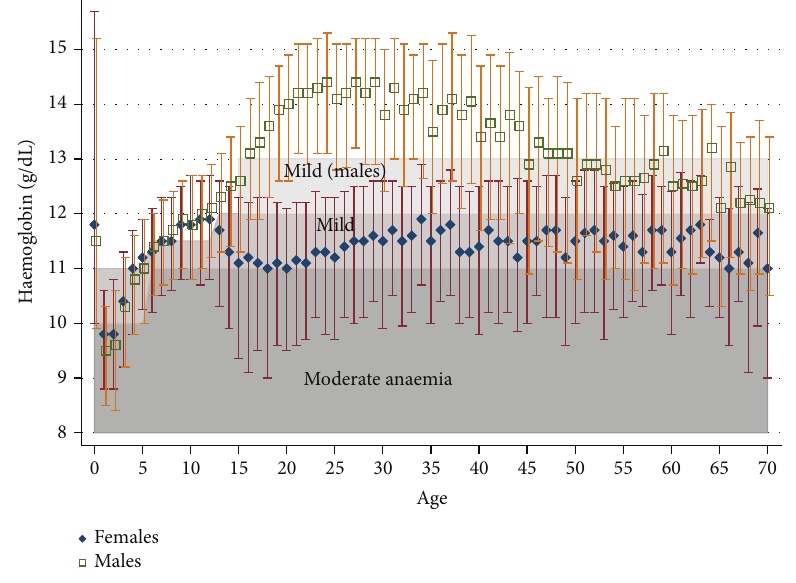
Figure 2: Median and interquartile range of haemoglobin concentration stratified by gender and age.